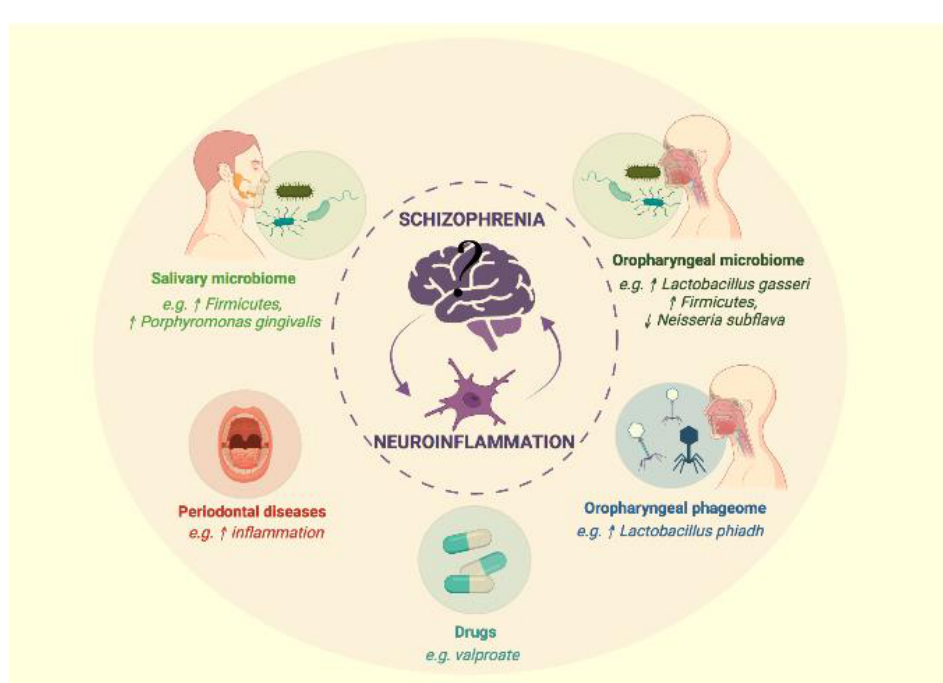
Figure 1. Link between oral microbiota and schizophrenia. (Figure created with Biorender.com, accessed on 25 December 2021)